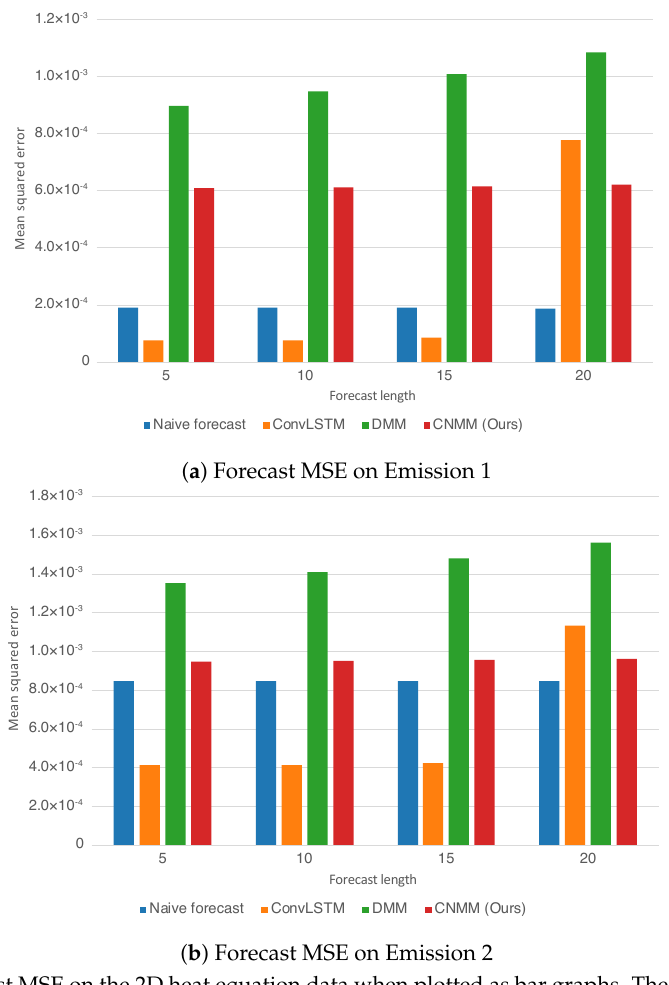
Figure 4. Forecast MSE on the 2D heat equation data when plotted as bar graphs. The y-axis represents the MSE. The x-axis represents the forecast length and the model with which the forecast is produced.